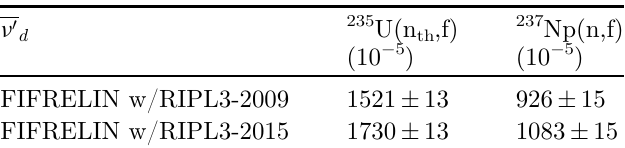
Table 3. Delayed neutron fraction for thermal fi ssion of 235 U and 800 keV neutron induced fi ssion of 237